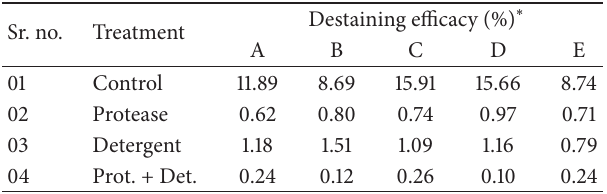
Table 4: Destaining profile of different blood stains after 25 min of